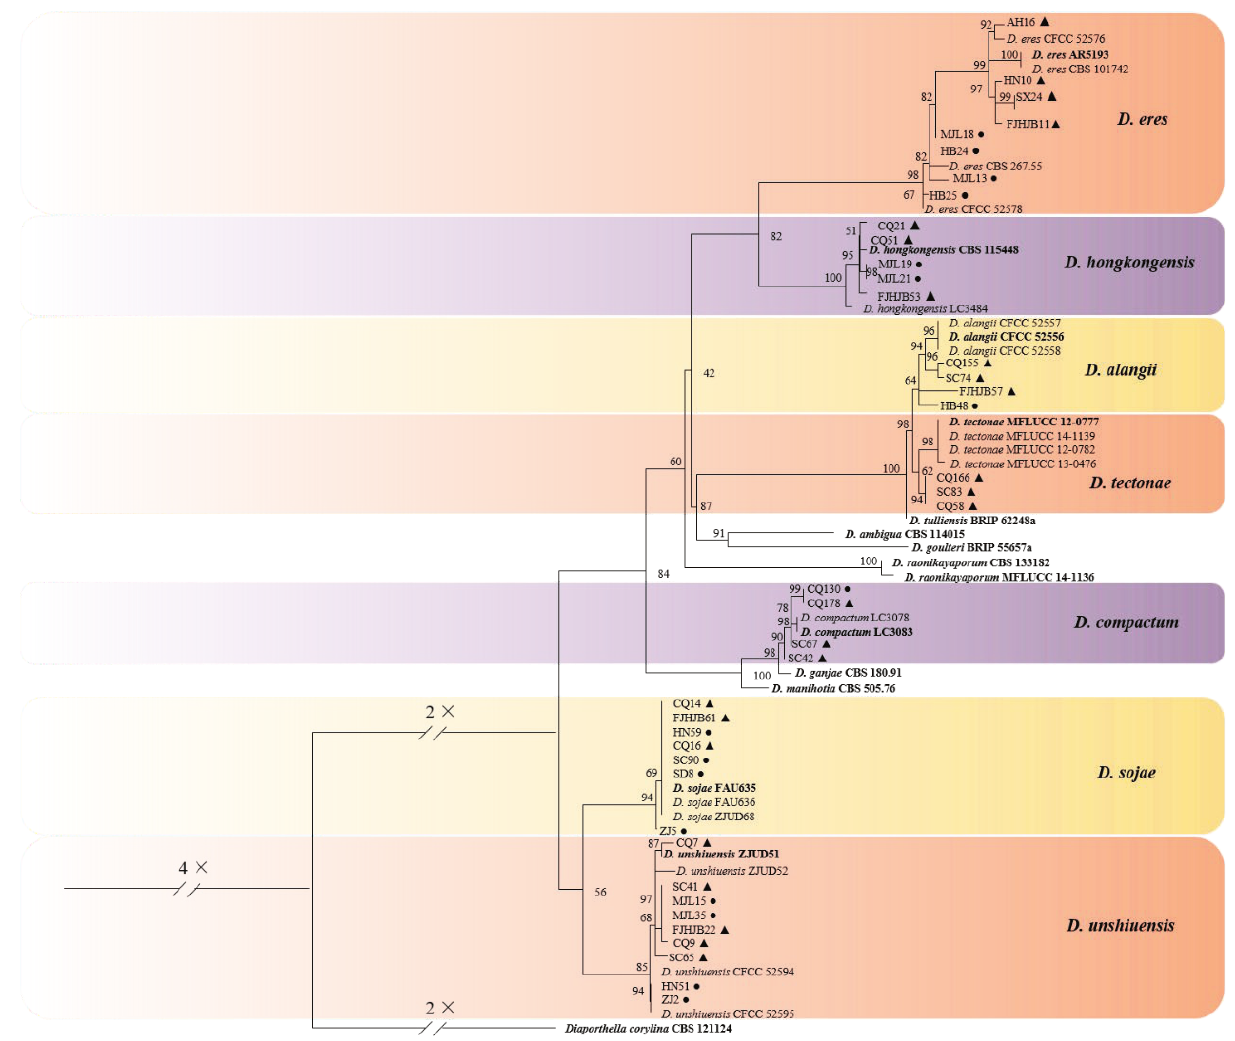
Figure 3. Maximum likelihood tree based on TUB sequences from 43 Diaporthe isolates. The species Diaporthella corylina (CBS 121124) was used as the outgroup. Bootstrap support values > 50% are shown at the nodes. Ex-type strains are indicated in bold font. The scale bar indicates 0.04 expected changes per site. Circle symbols indicate strains isolated from leaves, triangle symbols indicate strains isolated from